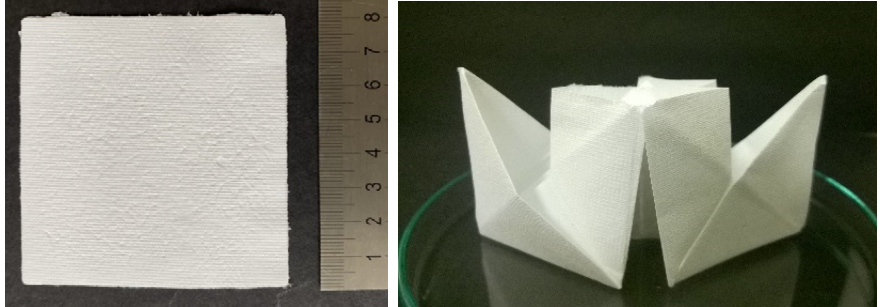
Figure 3. Photograph of an 8 × 8 cm nonwoven textile ( left ) and of the same textile folded into a paper ship ( right ), illustrating that the textile can be easily folded without breakage. The mass per area of the textile depends on the amount of polymer used for its preparation. Using the procedure and dosing described in Section 2.2, the obtained HA textiles had a mass per area of 4.8 ± 0.45 mg/cm 2